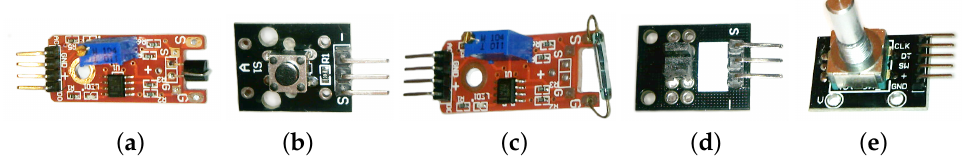
Figure 14. Other tested sensors: ( a ) another touch sensor; ( b ) button; ( c ) reed switch; ( d ) photo interrupt sensor; ( e ) rotary